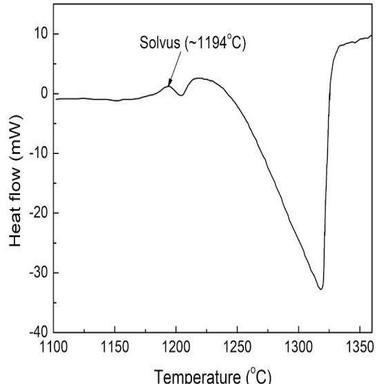
DSC heating curve of the advanced superalloy thermally scanned at 10K/min.